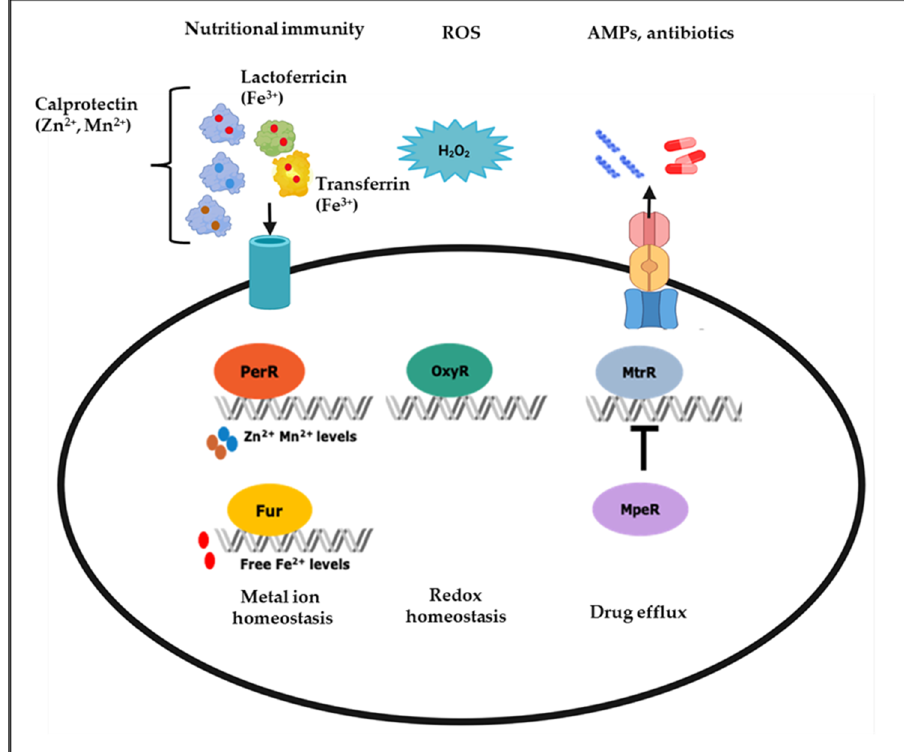
Figure 1. Transcriptional regulators in N. gonorrhoeae respond to various stress stimuli. Nutri- tional immunity: Essential trace metals such as Fe 3+ , Zn 2+ , and Mn 2+ are sequestered from pathogens by being stored in host proteins, such as lactoferricin (Fe 3+ ), transferrin (Fe 3+ ), and calprotectin (Zn 2+, Mn 2+ ). The transcriptional regulators Fur and PerR control the expression of genes involved in metal homeostasis, including surface-expressed metal transport proteins that scavenge metals for N. gonorrhoeae . ROS: the redox-responsive protein OxyR responds to the ROS and H 2 O 2 , and maintains redox homeostasis by regulating the expression of antioxidant genes. AMPs and antibiotics : efflux pumps that remove AMPs and antibiotics are negatively regulated by MtrR, which is itself nega- tively regulated by a second DNA-binding protein, MpeR, such that MpeR positively regulates ef- flux pumps indirectly. The figure was created with Biorender.com.